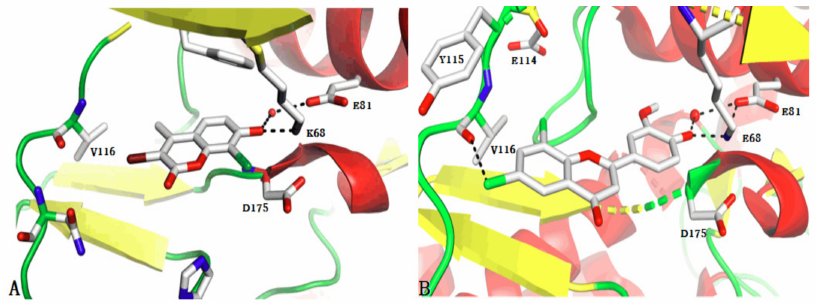
Figure 3. Binding modes of compounds 73 ( A ) and 2 ( B ) with CK2 indicated from molecular